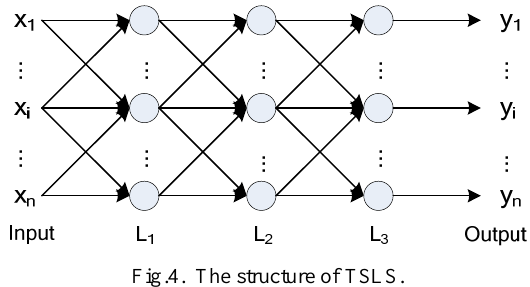
Fig.4. The structure of